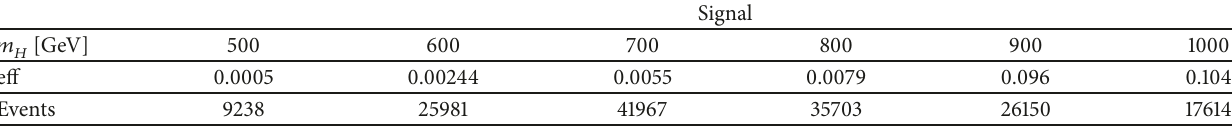
Table 3: Signal selection efficiencies and number of events at tan 𝛽 = 0.5 before the mass window cut.